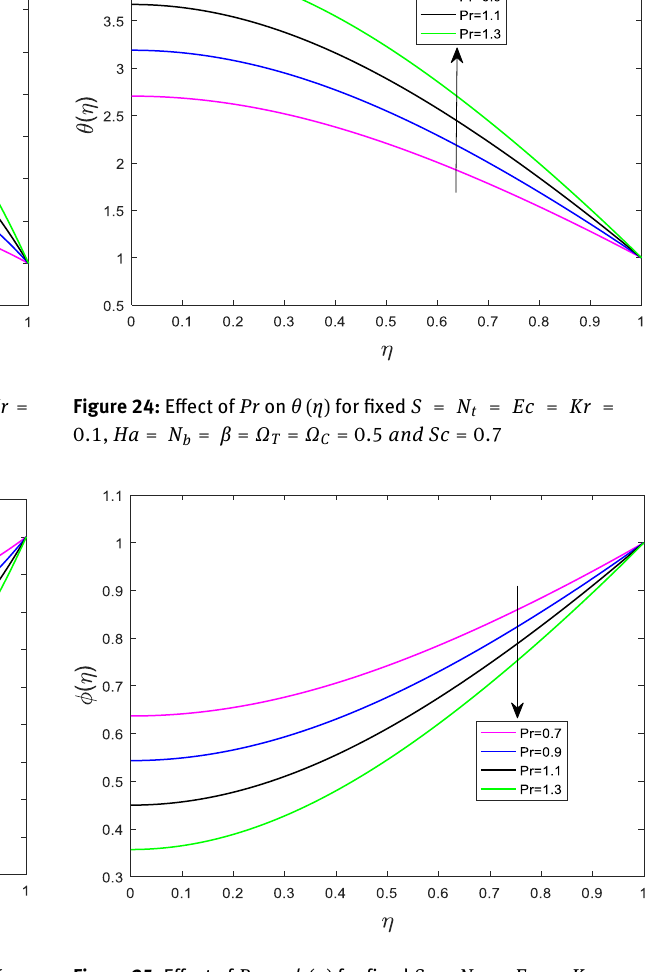
= β = Ω = 0.5, Pr = 0.7, and Sc = 0.7 T b